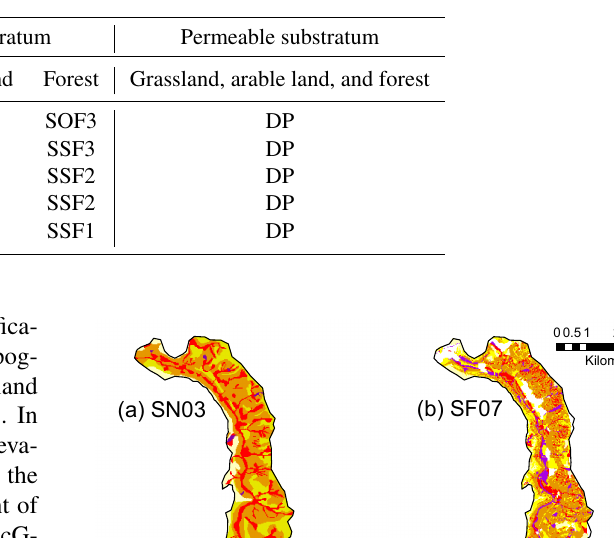
Table 3. Dependency of the DRP on the slope and permeability of the substratum for grassland, arable land and forest, according to Müller et al. (2009).